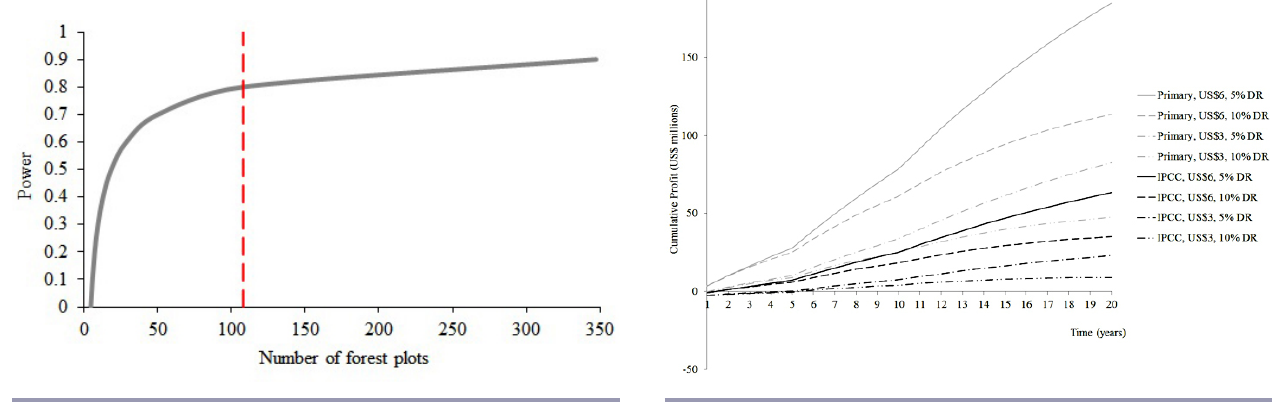
Fig. 3 . Power curve showing the total number of forest plots required to accept the outcome with given level of confidence. The figure demonstrates that 108 forest plots achieve a power of 80%, or 20% precision, and that increasing this precision to 10% would require 347 forest plots to be surveyed.